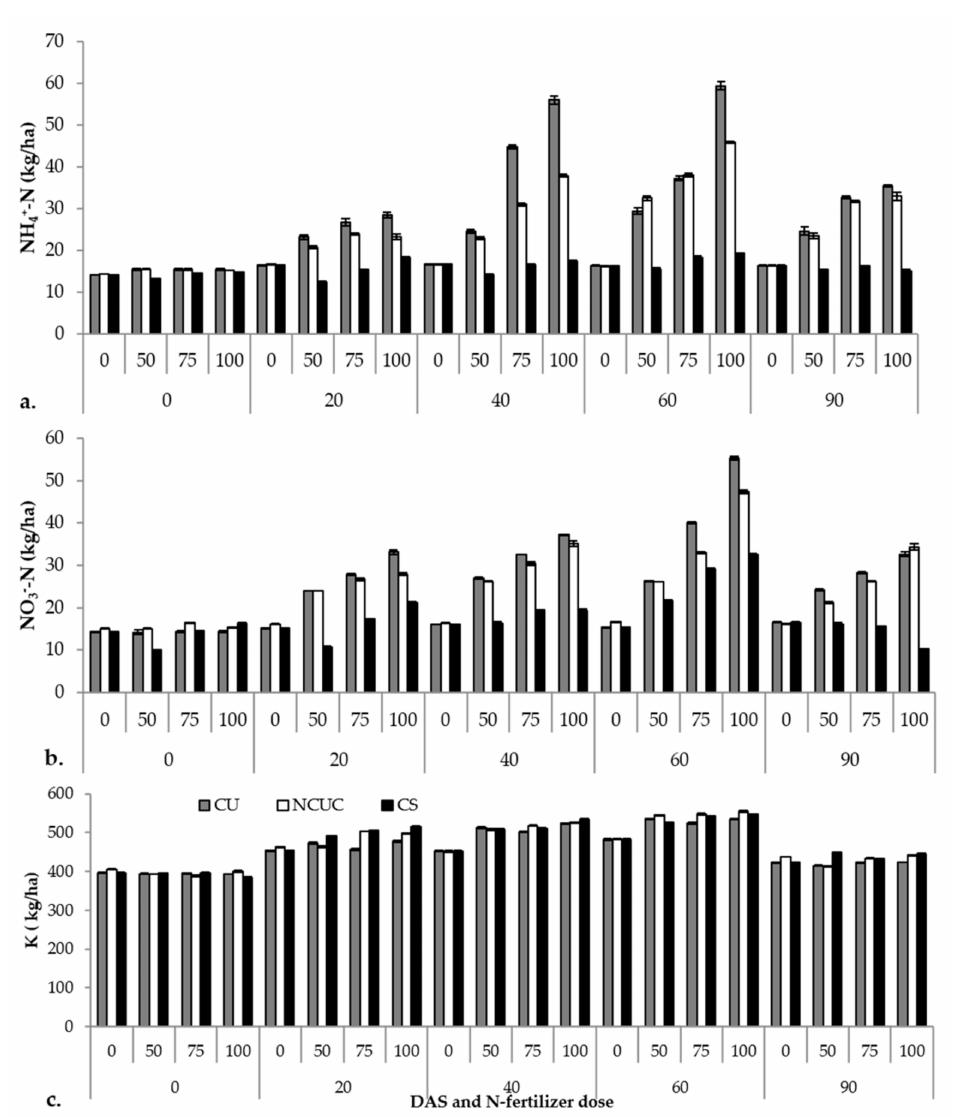
Figure 3. Effect of application of different types of N fertilizers on soil ammonical N ( a ), nitrate N ( b ) and K ( c ) contents of the soil samples under potato